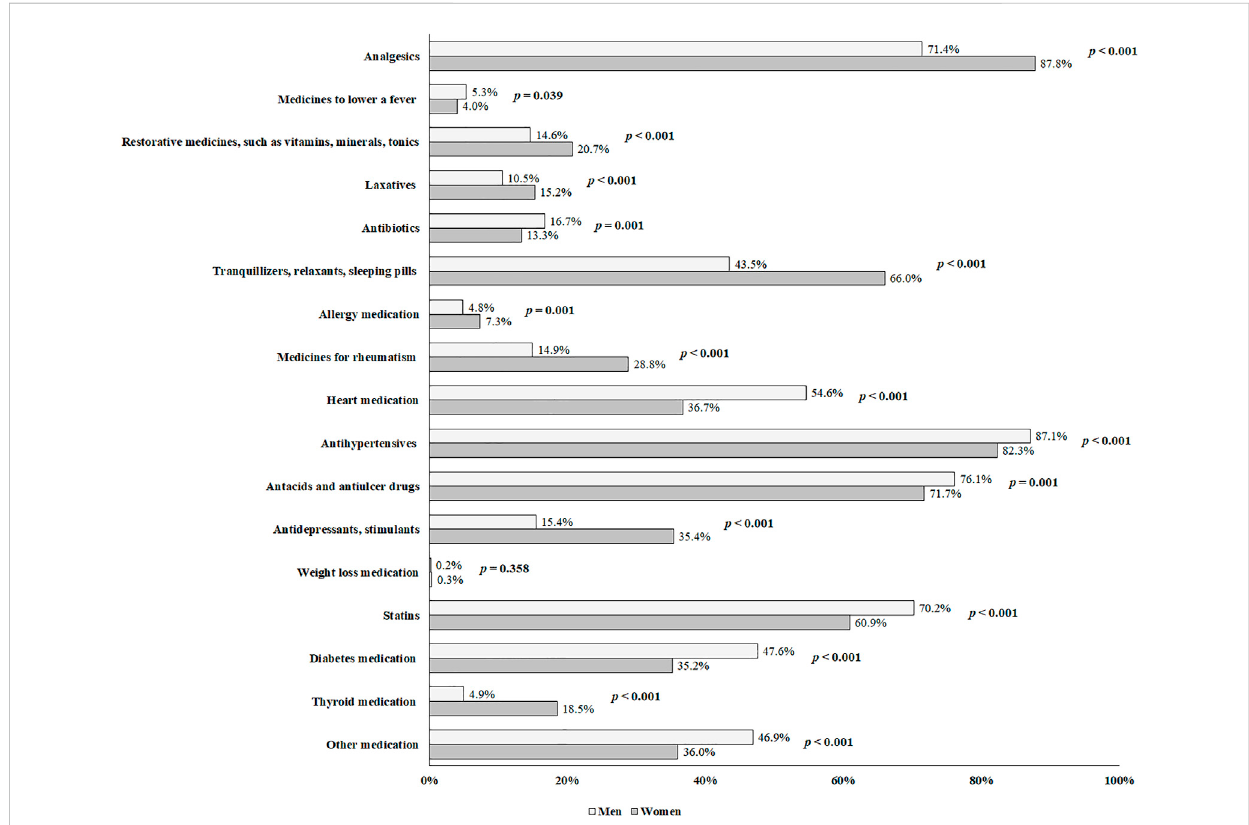
FIGURE 2 Distribution of medicine use in adults with polypharmacy ≥ 65 years old between men and women ( n =